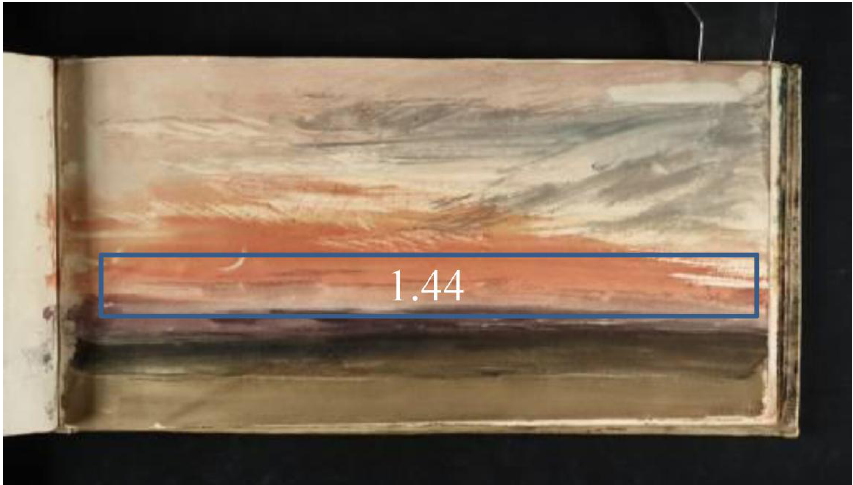
Fig. C4. Joseph Mallord William Turner, Red sky and crescent moon, c. 1818. Corresponding R/G ratios were averaged inside the box.